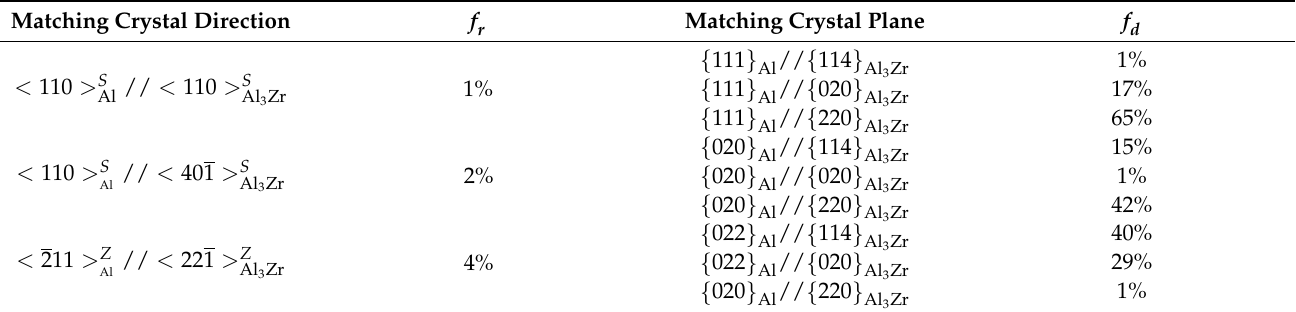
Table 2. Result of calculations [28].